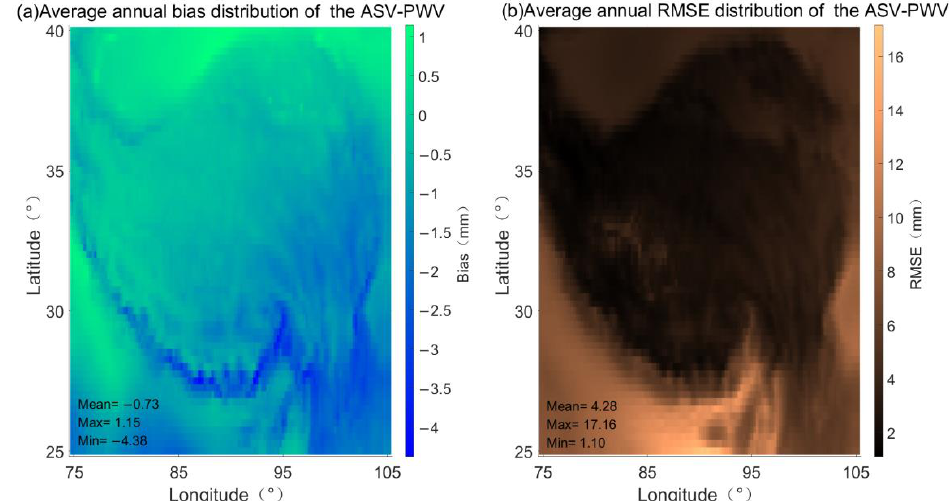
Figure 9. Average annual bias and RMSE distribution of the ASV-PWV (with respect to the ERA5 reanalysis PWV products).